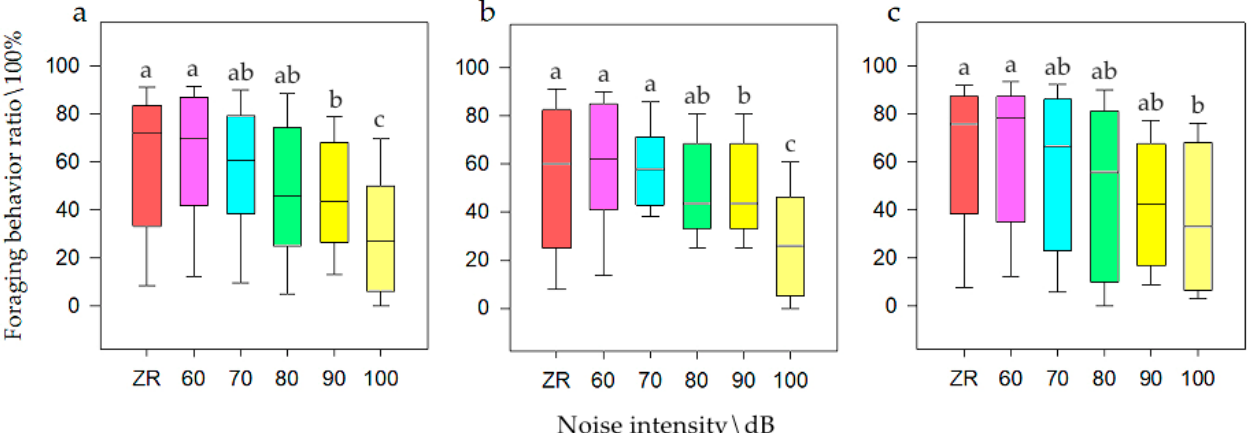
Figure 2. Foraging behavior of bean geese (( a ) Population N; ( b ) Population N1; ( c ) Population N2) of different noise intensity (ZR (background noise), 60, 70, 80, 90, and 100 dB). Different letters in the graphs represent significant differences from one-way ANOVA and SNK test. Bars represent means; error bars denote standard deviations. The bar with the highest foraging behavior ratio is marked as “a”. The foraging behavior ratio is compared with other noise gradients, and the difference is significant, marked as “b” and “c”.